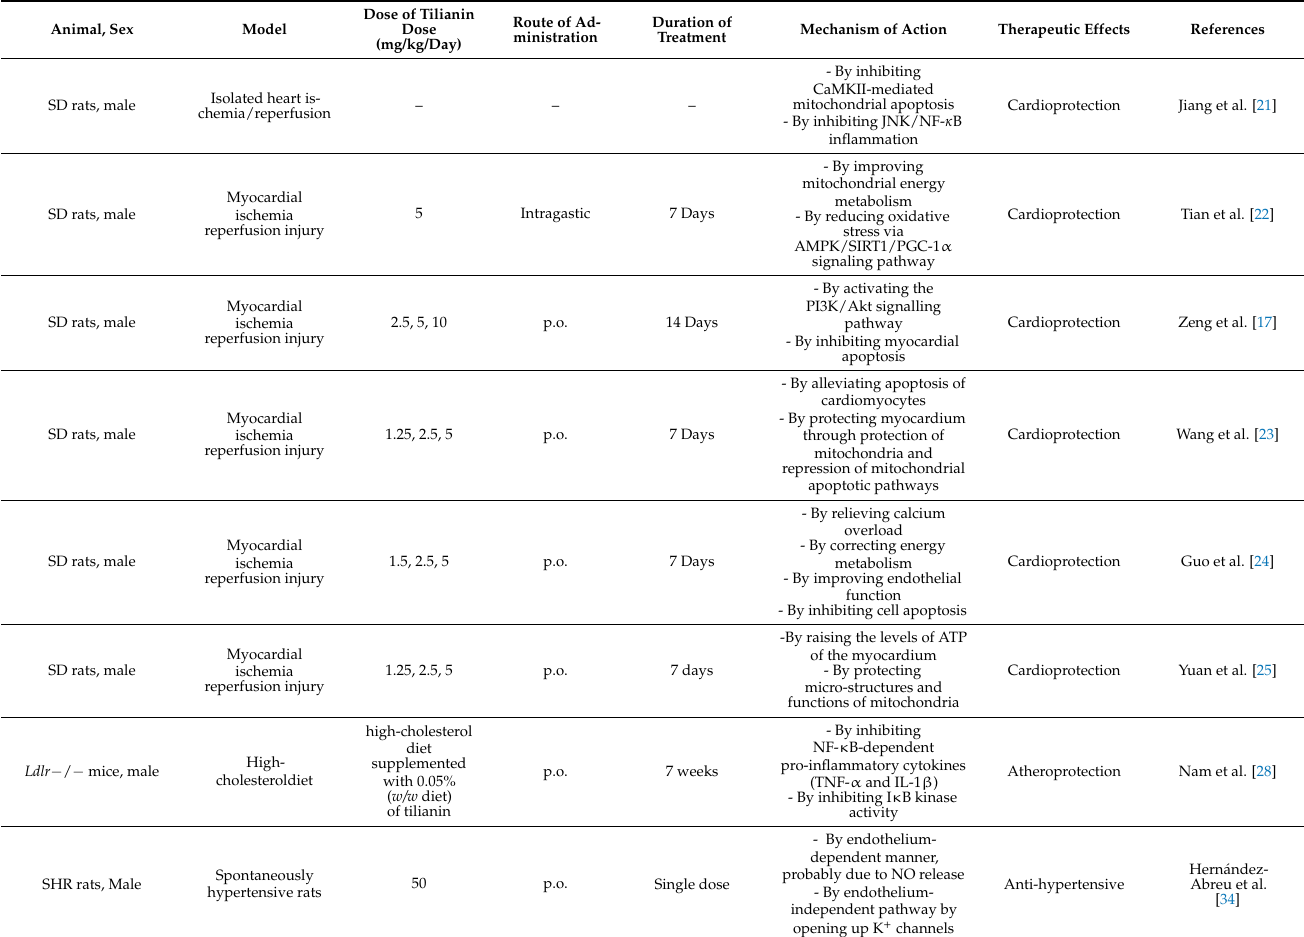
Table 1. A summary of in vivo studies investigated the efficacy of tilianin against